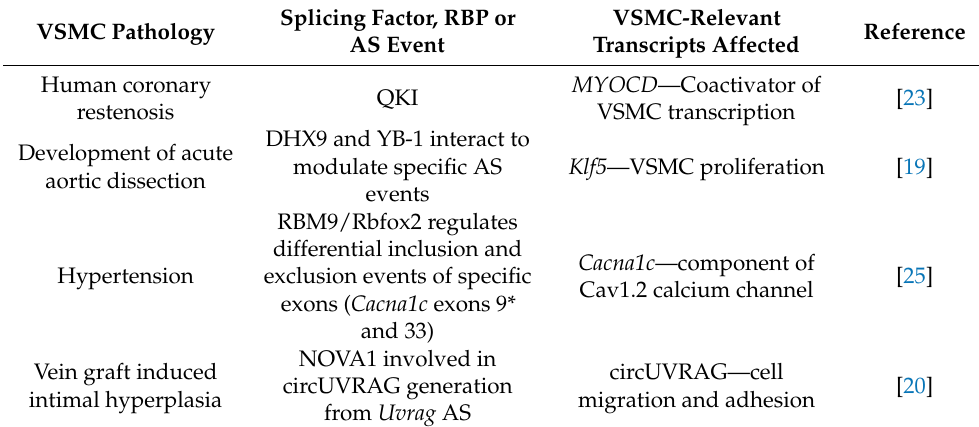
Table 2. Summary of primary regulators and outcomes of alternative splicing in vascular smooth muscle cell